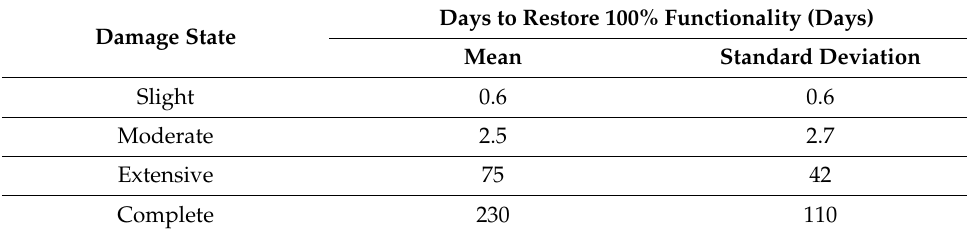
Table 10. Parameters of HAZUS restoration